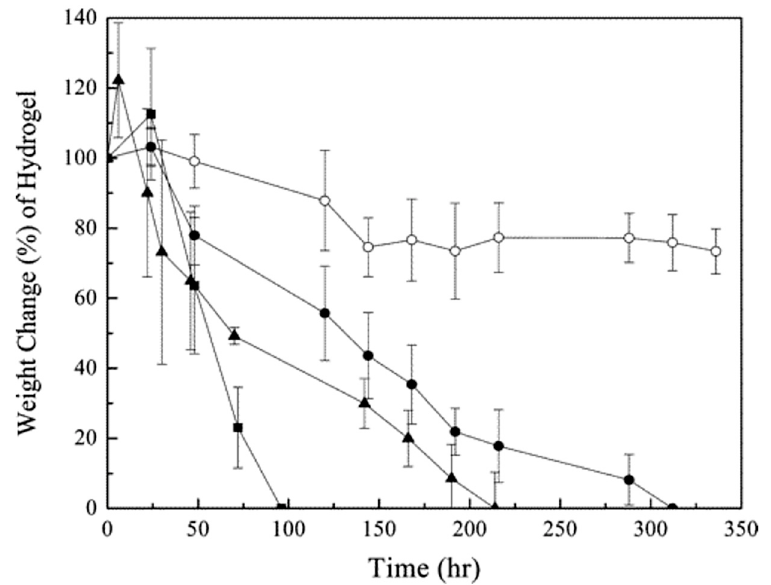
Figure 9. Degradation of peptide-linked pNIPAAm- co -AAc hydrogels with di ff erent crosslinkers in collagenase solution [142]. Reproduced from [142] with permission. Copyright (2003) American Chemical Society.